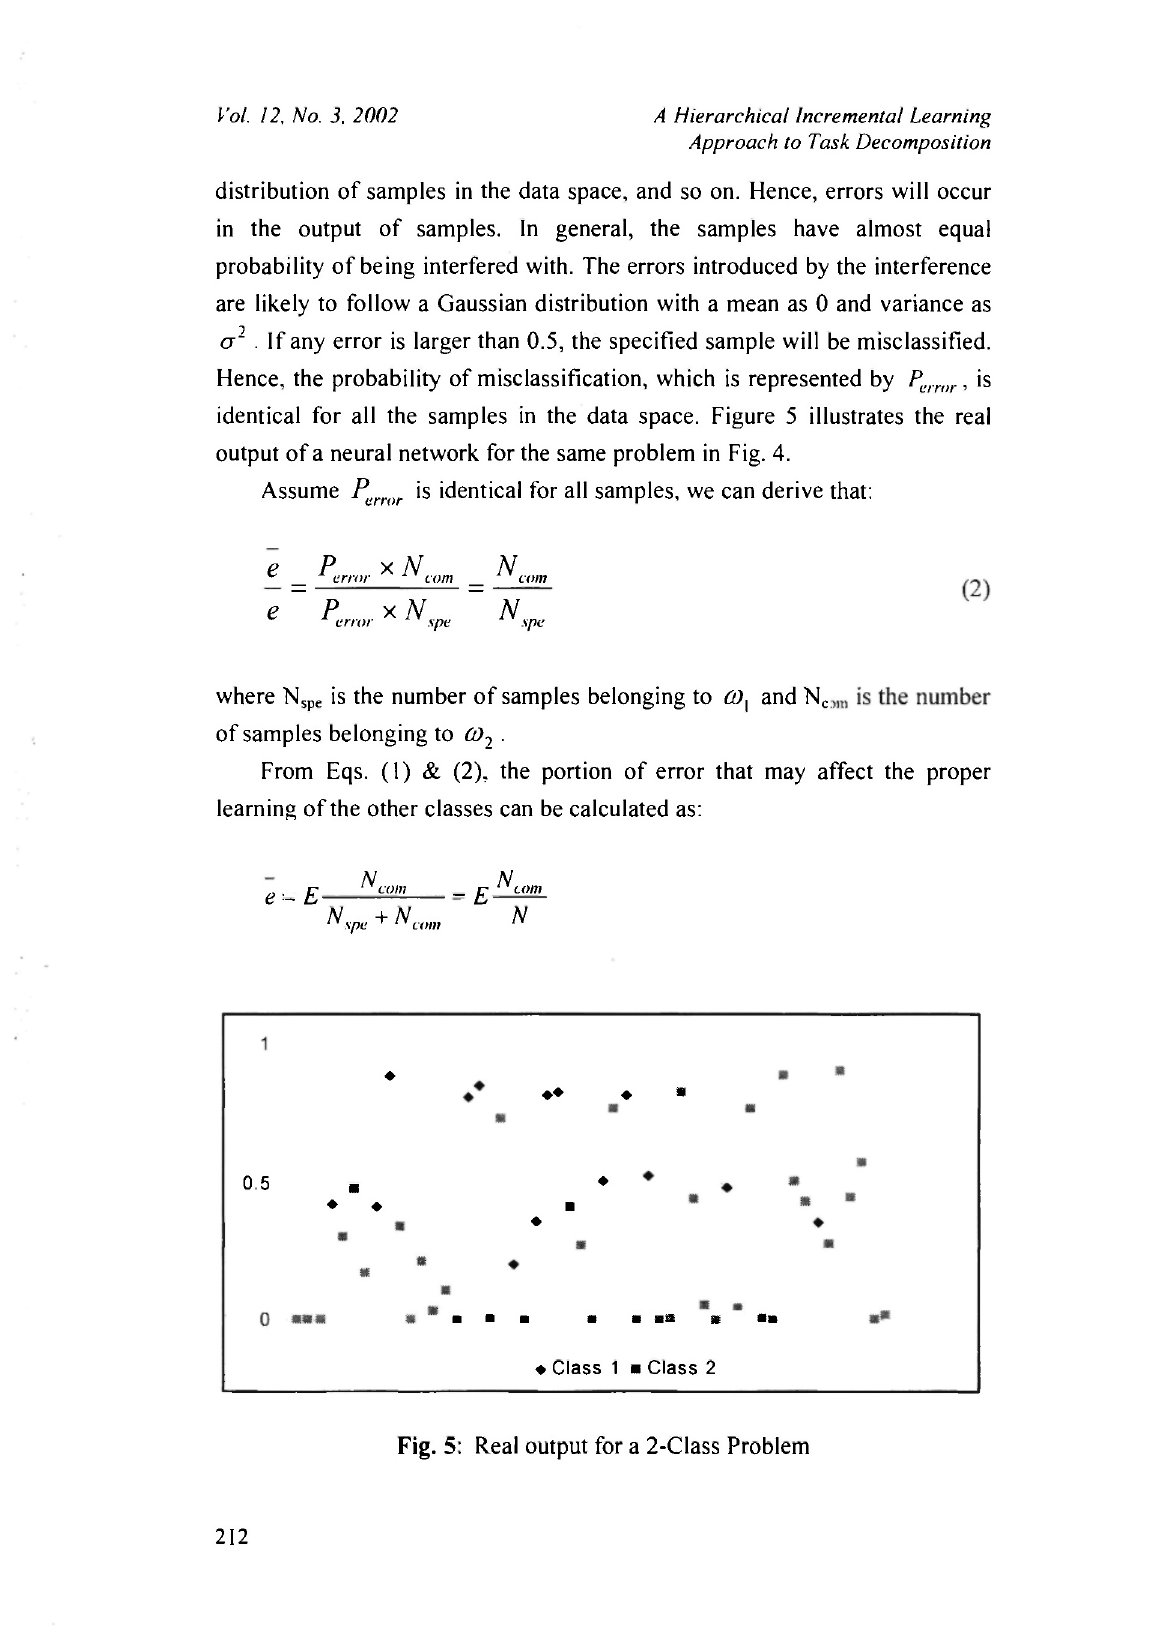
Fig. 5: Real output for a 2-Class